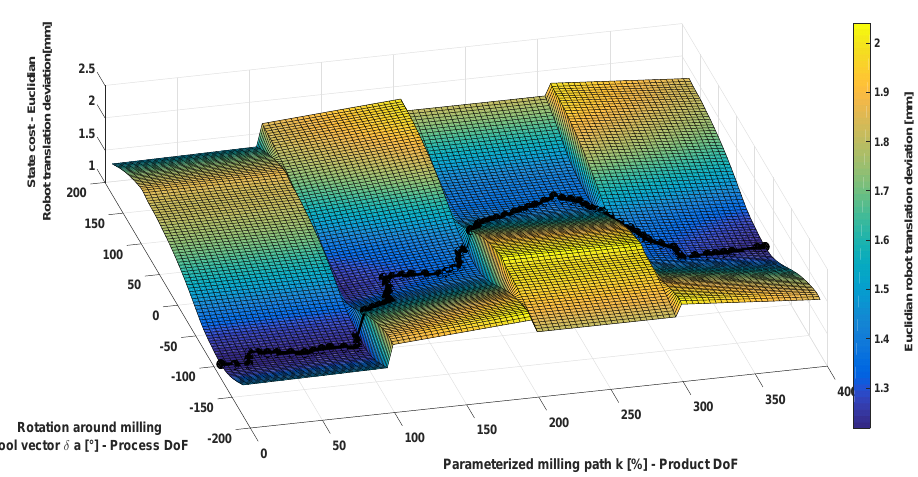
Figure 10. State cost elevation map illustration of the motion planning problem for optimizing stiffness.